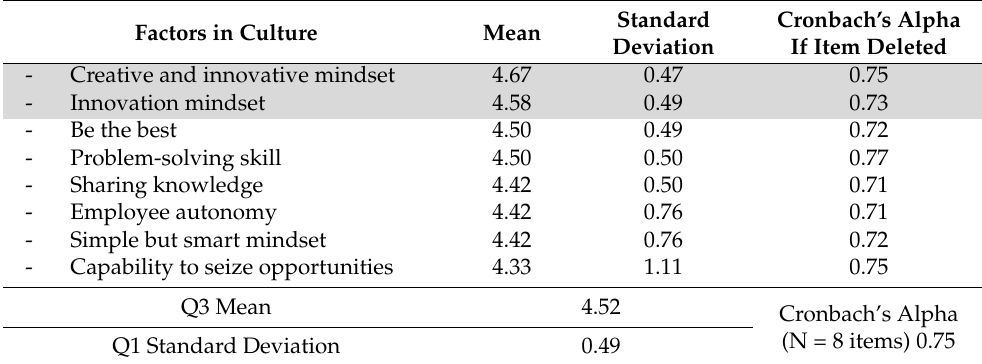
Table 9. Calculation of Q3 mean and Q1 standard deviation of cultural indicator factors.